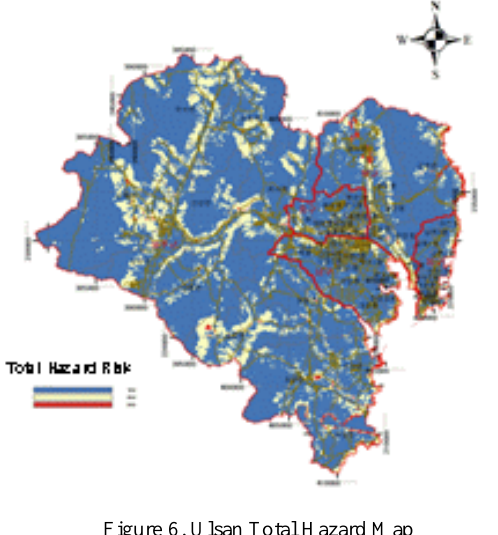
Figure 6. Ulsan Total Hazard Map